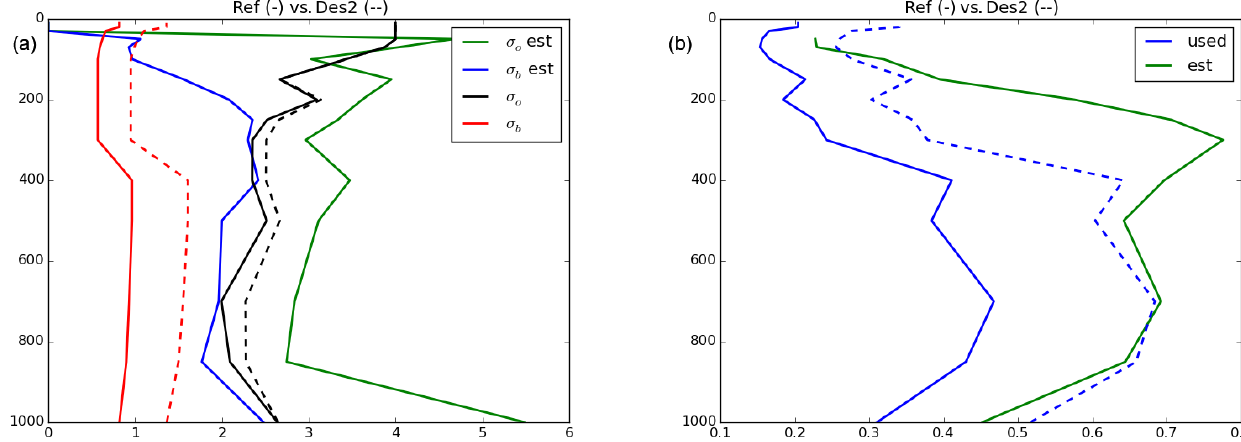
Figure 7. (a) The mean standard deviation of the background error ( σ B , red line) and the observation error ( σ O , black) used by the data assimilation and the estimated values of σ B (blue) and σ O (green) from the Desroziers diagnostics. The settings for the updated data assimi- lation are drawn with dashed lines. (b) The ratio σ B /σ O between what was used (blue solid line) and the estimated ratio (green solid line) as well as the ratio used in the experiment with updated settings (blue dashed